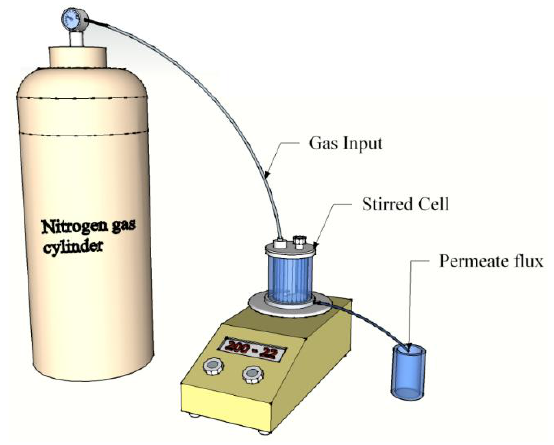
Figure 3. Schematic diagram of dead-end filtration.